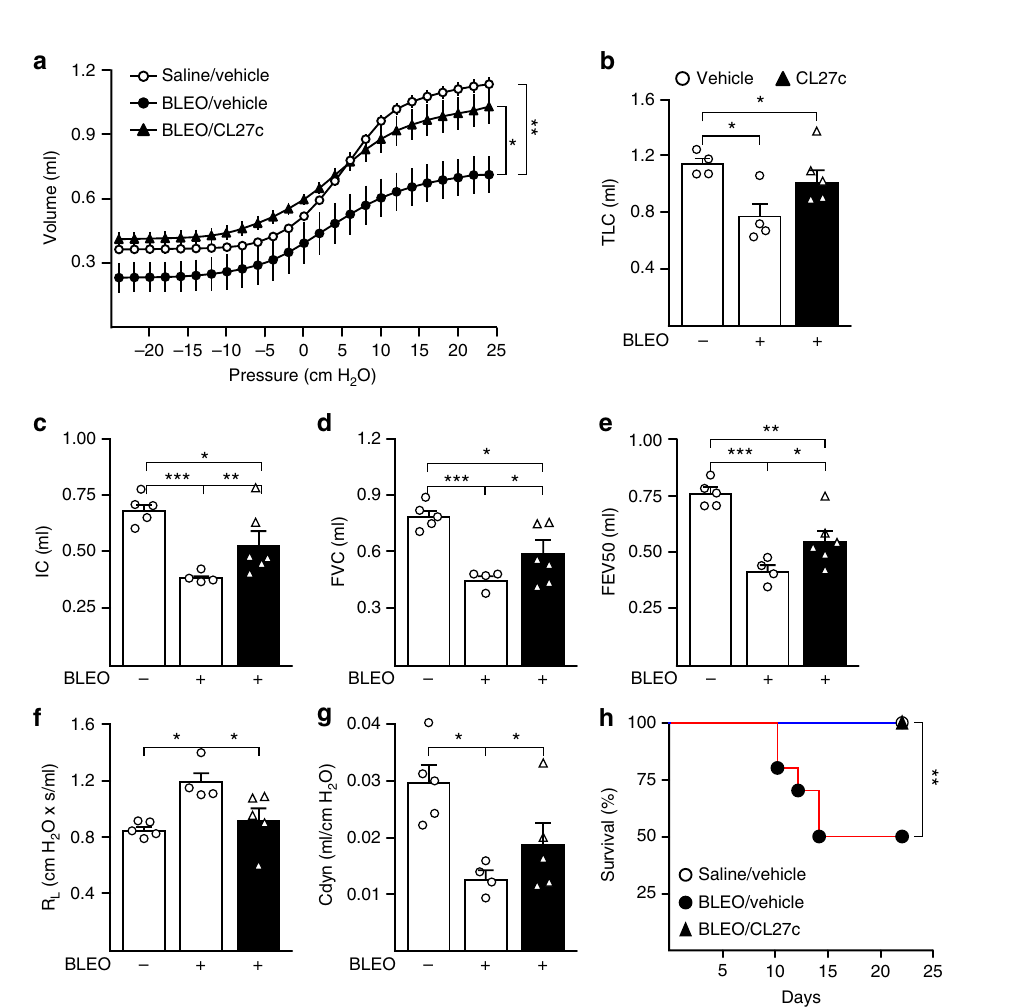
Fig. 8 CL27c treatment restores normal lung function and improves survival in a moderate model Bleomycin-induced lung fi brosis and dysfunction. a Analysis of the pressure – volume curve in control mice ( n = 14) and in mice that developed Bleomycin-induced lung dysfunction after treatment with vehicle ( n = 12) or CL27c ( n = 12; 2 mg/ml). b Analysis of total lung capacity (TLC) as in A (from left to right n = 4, 4, 5 independent experiments, respectively). c Analysis of inspiratory capacity (IC) as in ( a ) (from left to right n = 5, 4, 6 independent experiments, respectively). d Measurement of Forced vital capacity (FVC) as in ( a ) (from left to right n = 5, 4, 6 independent experiments, respectively). e Analysis of forced expiratory volume at 50 millisec (FEV50) as in ( a ) (from left to right n = 5, 4, 5 independent experiments, respectively). f Quanti fi cation of lung resistance (RL) as in ( a ) (from left to right n = 5, 4, 5 independent experiments, respectively). g Measurement of dynamic compliance (Cdyn) as in ( a ). h Survival curves of mice treated with either saline (white circles; n = 8) or Bleomycin in the presence (black triangles; n = 10) or absence (black circles; n = 10) of CL27c. Results represent mean ± s.e.m., * P < 0.05, ** P < 0.01, *** P < 0.001 determined using one-way ANOVA followed by Bonferroni post-hoc test. Animal survival was